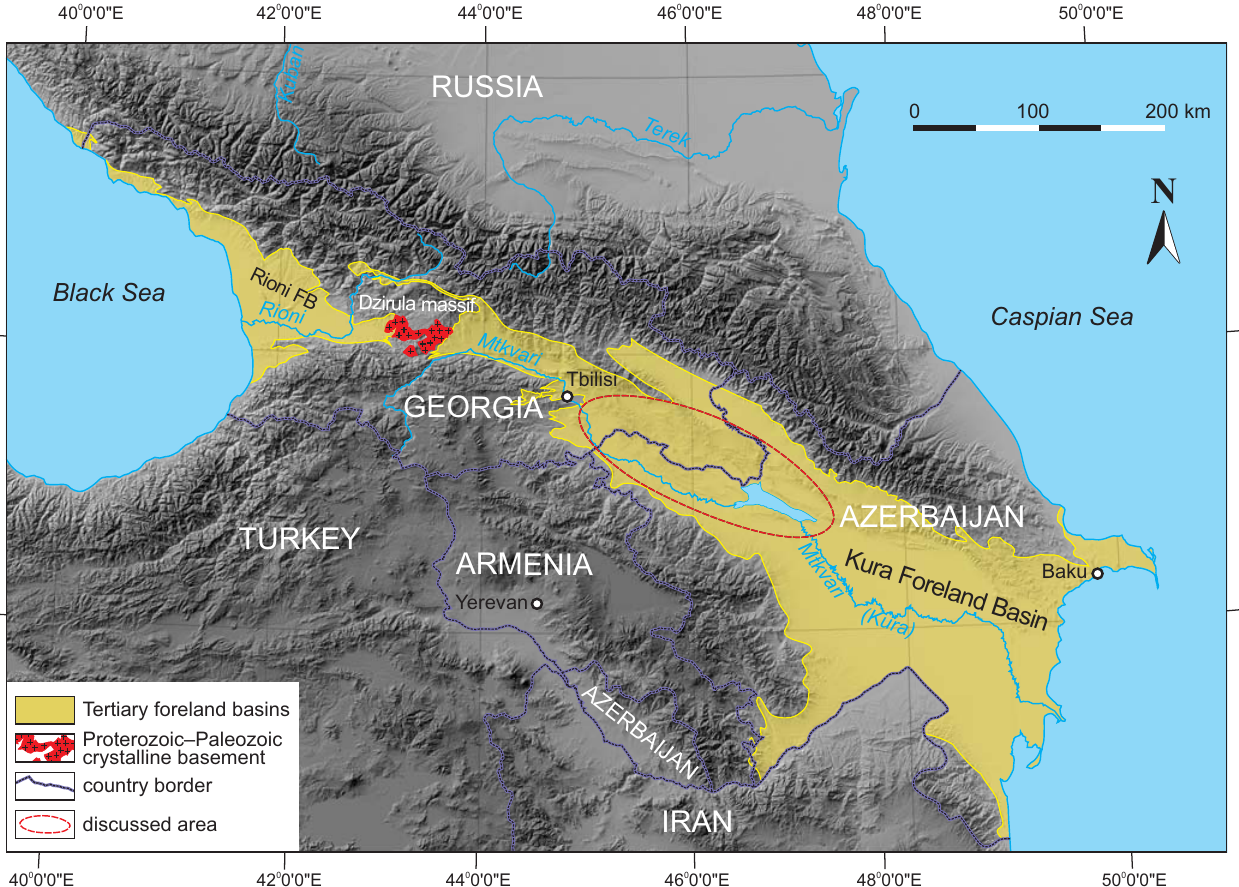
Fig. 1. Map of the Caucasus region showing the Tertiary foreland basins. Modified after Mauvilly et al. (2016); Mauvilly (2017). Topographic map from the United States Geological Survey (USGS) earth explorer web-based platform https://earthexplorer.usgs.gov. FB, foreland basin.